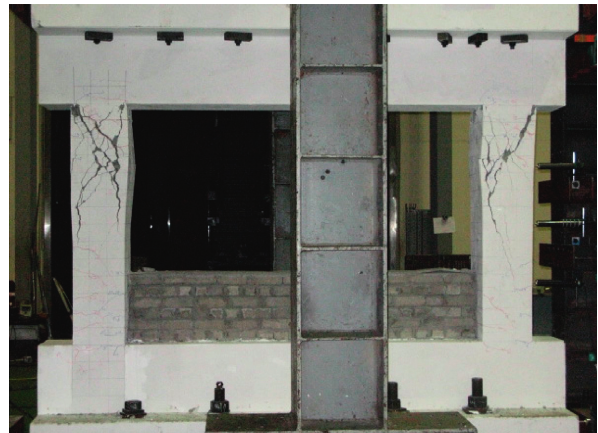
Figure 19: Cracks observed in the C-RC specimen during cyclic loading.